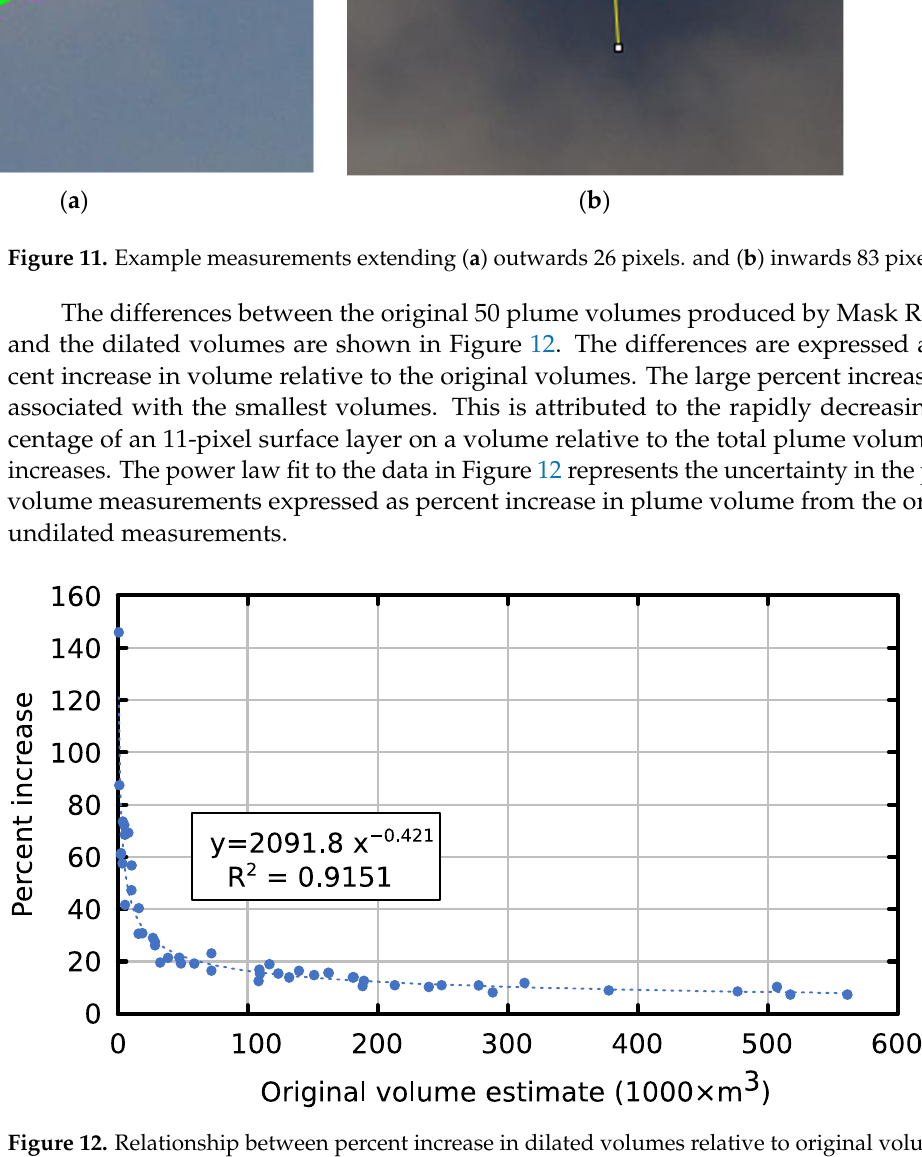
Figure 11. Example measurements extending ( a ) outwards 26 pixels. and ( b ) inwards 83 pixels.